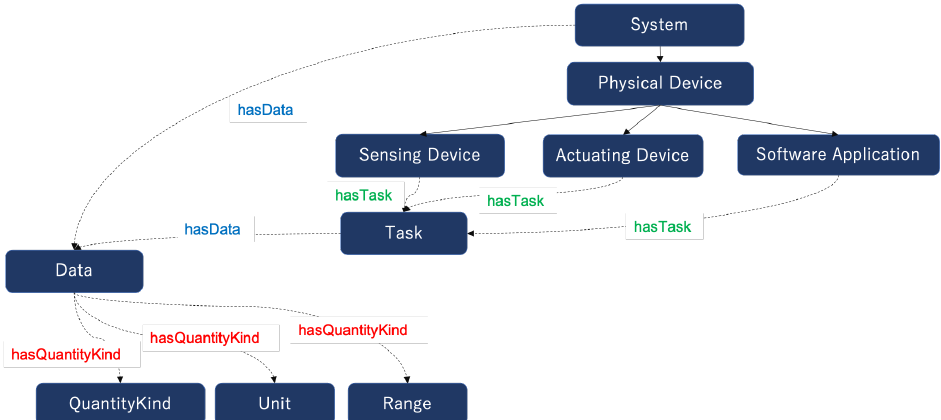
Figure 12. Ontology tree of the IoT system with